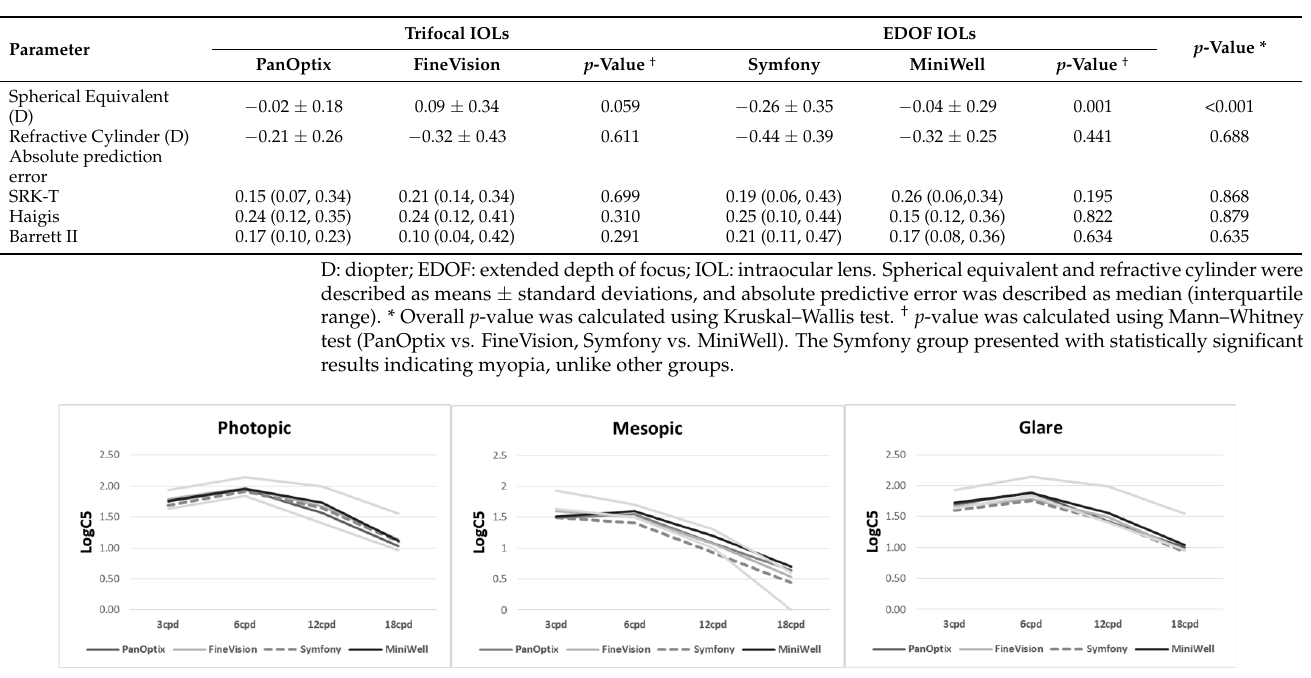
Figure 3. Contrast sensitivity with PanOptix, FineVision, Symfony, and MiniWell. There were no statistical differences tested by analysis of variance among the contrast sensitivities at any spatial frequencies (3, 6, 12, and 18 cycle per degree (cpd)) under photopic condition ( p = 0.215, 0.847, 0.289, 0.538, respectively), mesopic condition without glare ( p = 0.391, 0.641, 0.223, 0.254, respectively), and mesopic condition with glare ( p = 0.365, 0.213, 0.437, 0.709, respectively).